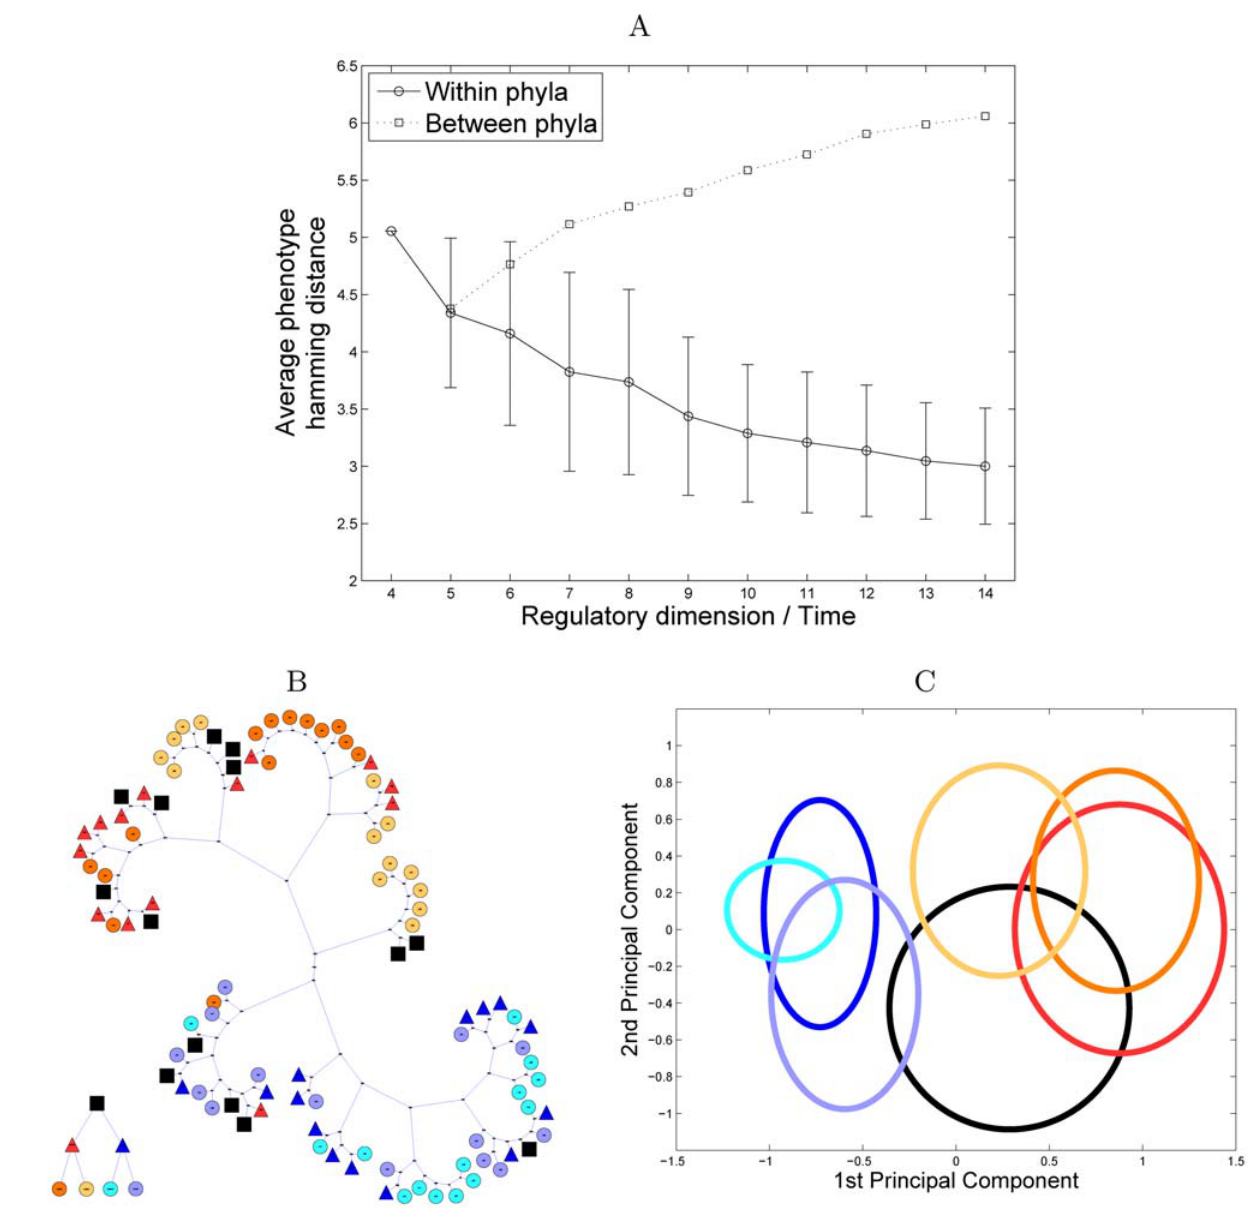
Figure 10. Phenotype distribution in an ontogenetic-phylogenetic model. (A) The average pairwise Hamming distance between visible phenotypes within and between phyla. Each phylum corresponds to a developmental plan, and the set of the most frequent visible phenotypes produced by this plan represent species. The ancestral phyla is employing a developmental plan with r =4 and k =14. In each branching event, each of the two descendant phyla add an additional regulatory element with random connectivities preserving the ancestral component of the developmental plan (Figure 9). This branching process continues until we get the 1024 most recent phyla, each employing a developmental plan with r =14 and k =14. (B) A phylogenetic tree including phenotypes from derived and ancestral phyla. The tree is reconstructed by computing the pairwise Hamming distance matrix between all phenotypes and applying a neighbor-joining algorithms. Rectangular, triangular, and circular nodes represent phenotypes from the ancestral phylum, intermediate phyla, and derived phyla respectively. Phyla within each phylogenetic level are illustrated with different colors. The small tree on the bottom left corner illustrates the phylogenetic tree of different developmental plans (using the same color coding as that used in the main tree). Phenotypes (or ‘species’) of different phyla differ only in the developmental plan and not in genotype, but the resulting tree successfully clusters the members of each phyla. Furthermore, the members of intermediate phyla are correctly clustered, spanning the same phylogenetic space as their descendants. Members of the ancestral phylum (represented by black rectangles) span similar regions to those covered by all derived phenotypes. (C) Representation of ancestral, intermediate, and derived phenotypes according to the first two principle components. Ellipses illustrate the mean and variance for each phylum. The color coding is identical to that used in the phylogenetic tree.